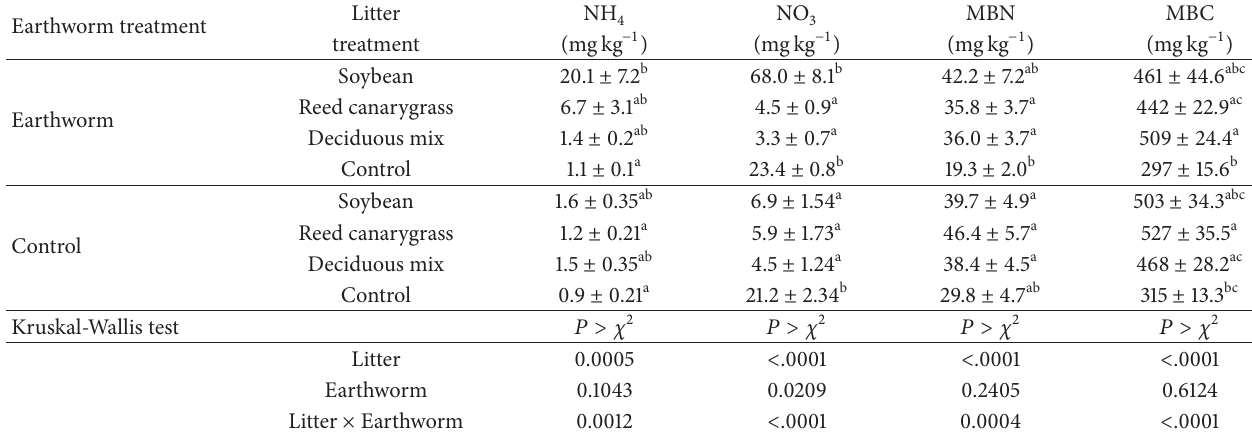
Table 4: Mean soil NH 4 , NO 3 , MBN, and MBC concentrations in microcosms containing riparian soils. Values are the average of nine sampling dates ( 𝑛 = 144 ). Within a column, values followed by the same letter are not significantly different ( 𝛼 = 0.05 ) according to Dunn- Nemenyi’s procedure for multiple